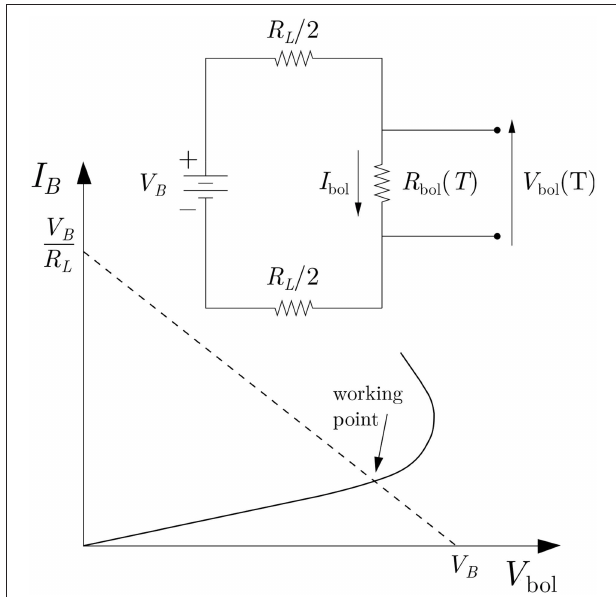
FIGURE 2 | (Top) Electric scheme of the biasing system used for the NTD readout. (Bottom) Typical load curve of a semiconductor thermistor. The working point is set as the intersection between the V - I characteristic curve V B I B R L and the load line V bol = −